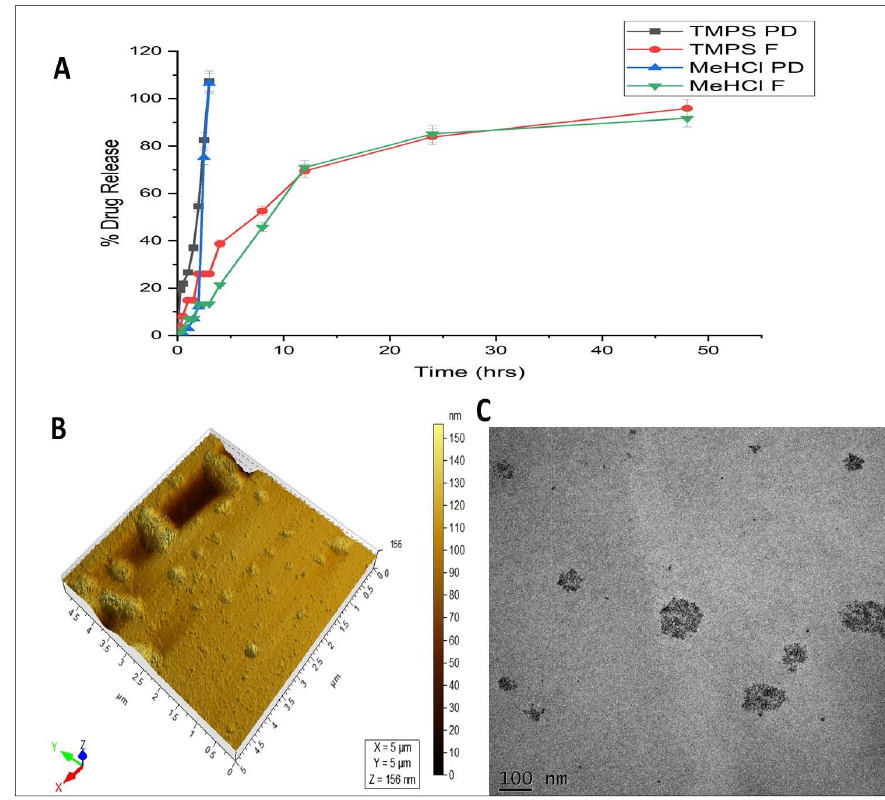
Figure 8. ( A ) Drug release profile of MeHCl & TMPS in pure form and SLNs where the data is represented in mean ± SD ( n = 3) ( B ) AFM image of M + T SLN ( C ) TEM micrographs of M + T loaded SLNs.